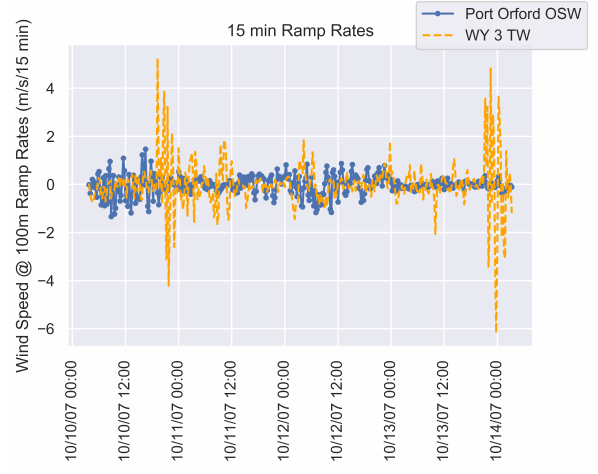
Figure 5. Fifteen-min ramp rates over a 96-h excerpt at the Port Orford and Wyoming locations.